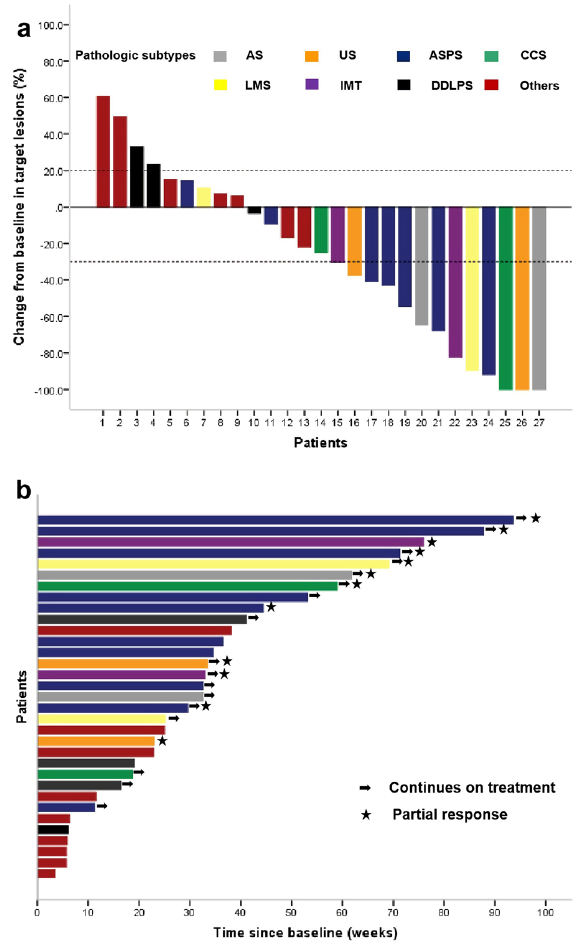
Figure 2. ( a ) Waterfall plot of the best percentage change from baseline in target lesions in 27 evaluable patients. AS, Angiosarcoma; US, Undifferentiated sarcoma; ASPS, Alveolar soft-part sarcoma; CCS, Clear cell sarcoma; LMS, Leiomyosarcoma; IMT, Inflammatory Myofibroblastic Tumor; DDLPS, De-differentiated liposarcoma; Others include rhabdomyosarcoma (n = 1), myxofibrosarcoma (n = 1), undifferentiated pleomorphic sarcoma (n = 1), spindle cell sarcoma (n = 1), malignant peripheral nerve sheath tumour (n = 1), myofibroblastic sarcoma (n=1) and synovial sarcoma (n = 1). ( b ) Progression-free survival of patients. Each patient is represented by a horizontal bar (n = 33). The stars represent patients achieving objective responses. The arrows represent patients non-progressing during the last radiological